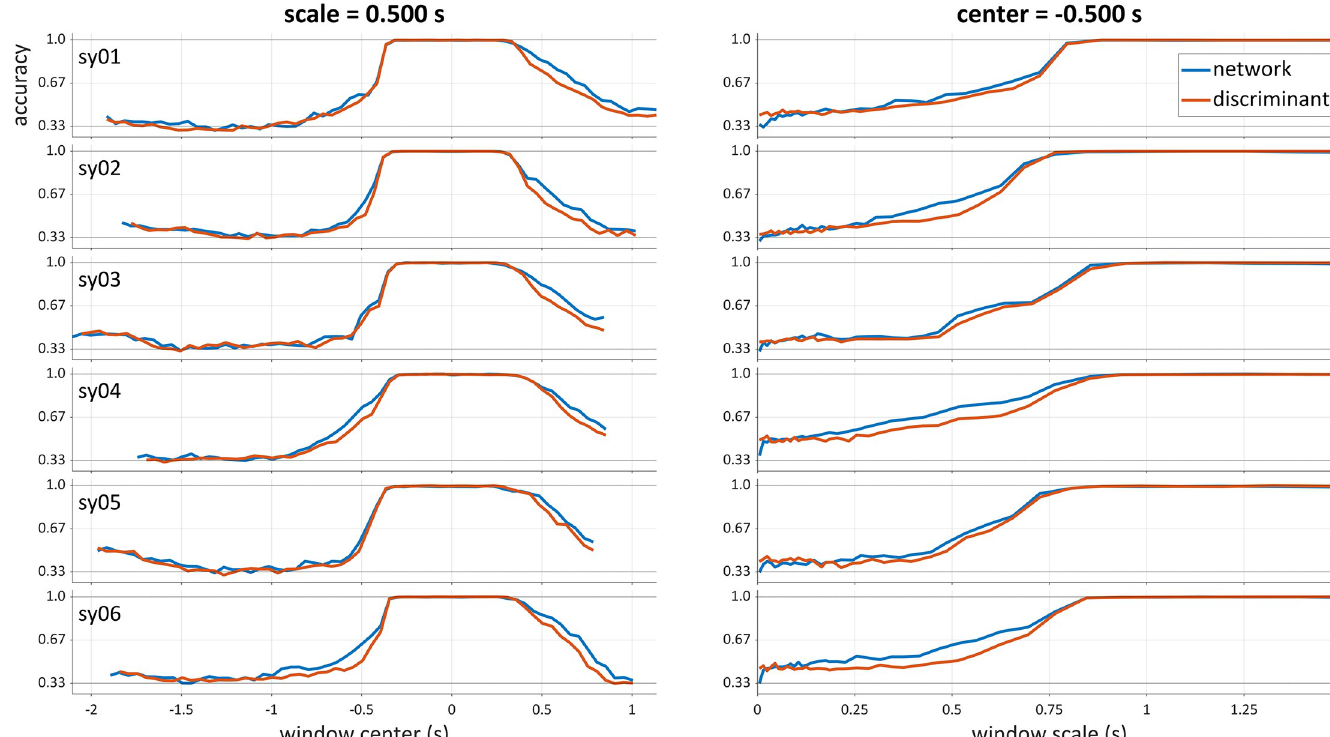
Fig 5. Comparison of accuracies of neural network and discriminant analyses for fixed scale and center. All six participants from the syllable production dataset are shown. Left: average accuracies as a function of window center, at scale 0.500 s. Right: accuracies as a function of window scale, at center -0.500 s. Blue line: network accuracy; orange line: linear discriminant